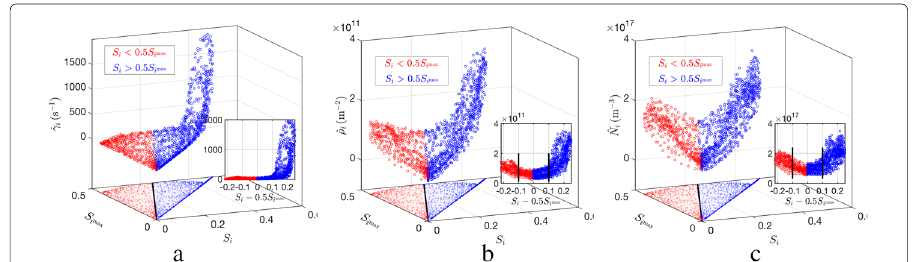
Fig. 4 DDD simulation values of a ˙ γ i , b ρ i , c N i at ˙ γ d = 0.5% as a function of S i and S i max . For clarity, data points are also projected onto the bottom plane. Inset figures show the same data plotted as a function of S i − 0.5 S i max , which is equivalent to viewing the data along the boundary line between red and blue data